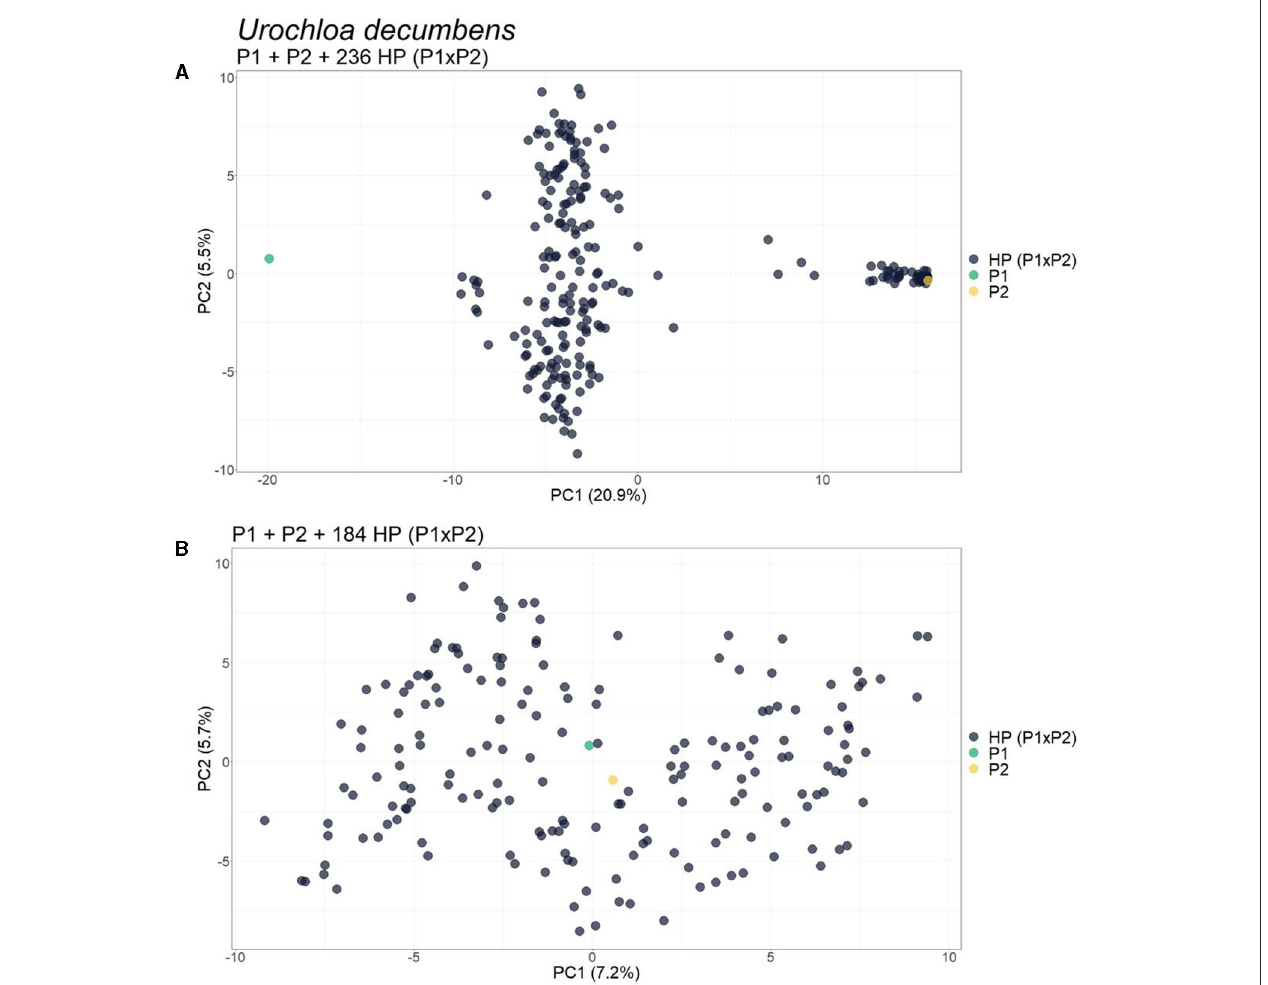
FIGURE 6 | Principal component analysis (PCA)-scatter plots showing the Urochloa decumbens progeny for the set of single nucleotide polymorphism (SNP) markers filtered by 0.05 for prop_mis . (A) Original population composed of two parents (P1 and P2) and their progeny of 236 hybrids [HP (P1 × P2)]; (B) Population without the 52 apomictic clones (ACs) identified. The axis represents the first and second principal components, explaining 20.9 and 5.5%, respectively, of the variance for (A) and 7.2 and 5.7% for (B)